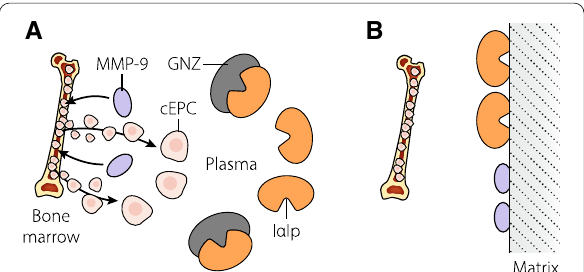
Fig. 2 Removal of protective proteins. A Inter-alpha inhibitor proteins (IαIp) inhibit granzymes (GNZ) and other proteases reducing their toxic proteolytic activity. Matrix metalloproteinase-9 (MMP-9) transits to bone marrow where it mobilizes circulating endothelial progenitor cells (cEPC) to the circulation, promoting healing of microvascular endothelium. B Where matrix adsorption binds IαIp its activity may be reduced leading to disinhibition of proteases which may be injurious. Where adsorption binds MMP-9, mobilization of restorative cEPC may be blunted and their systemic restorative effects diminished or